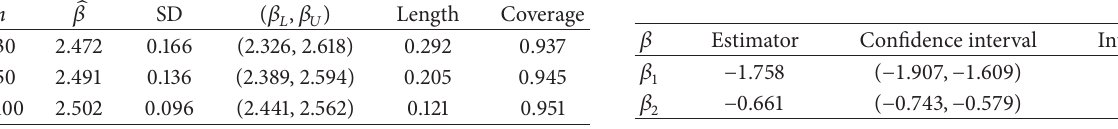
Figure 2: The corresponding coverage probabilities. Table 2: The estimators and the 95 % confidence intervals for 𝛽